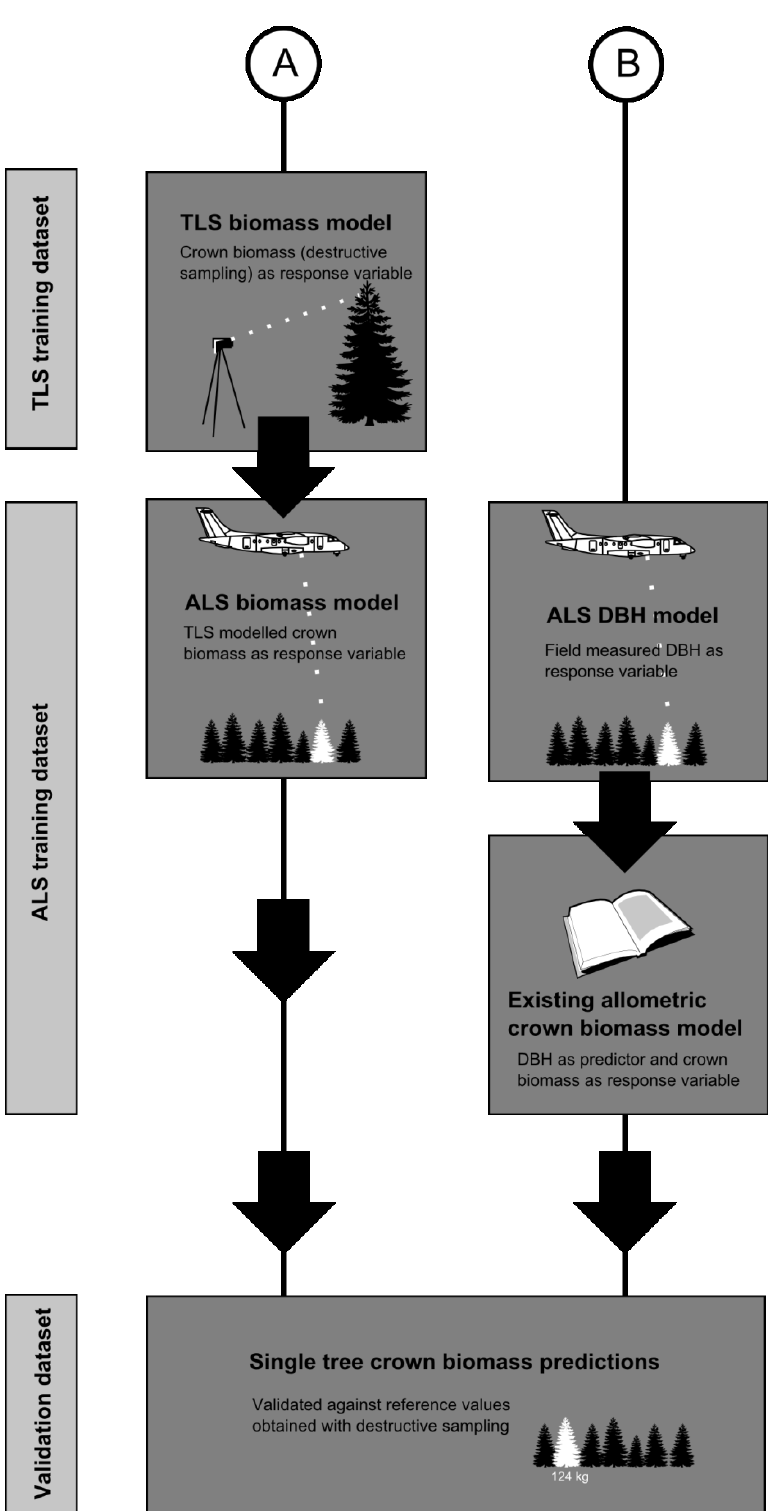
Figure 3. Outline of the two approaches that were compared in the present study: the approach with the use of TLS data ( A ) and the approach without the use of TLS data ( B ). In the former approach, crown biomass modelled from TLS data was used as the ground reference values in the subsequent ALS modelling process. The two methods were validated using one set of destructively sampled